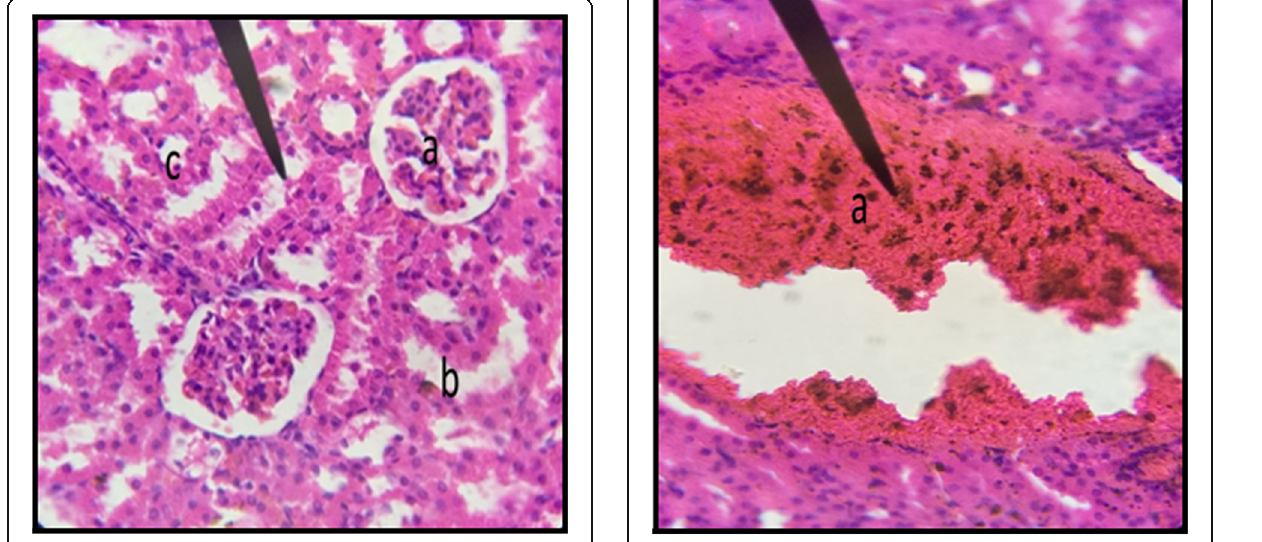
Fig. 6 Kidney Section of Female Rat (50 mg/kg/day) X400. a normal glomerulus, b normal distal tubule, c normal proximal tubule